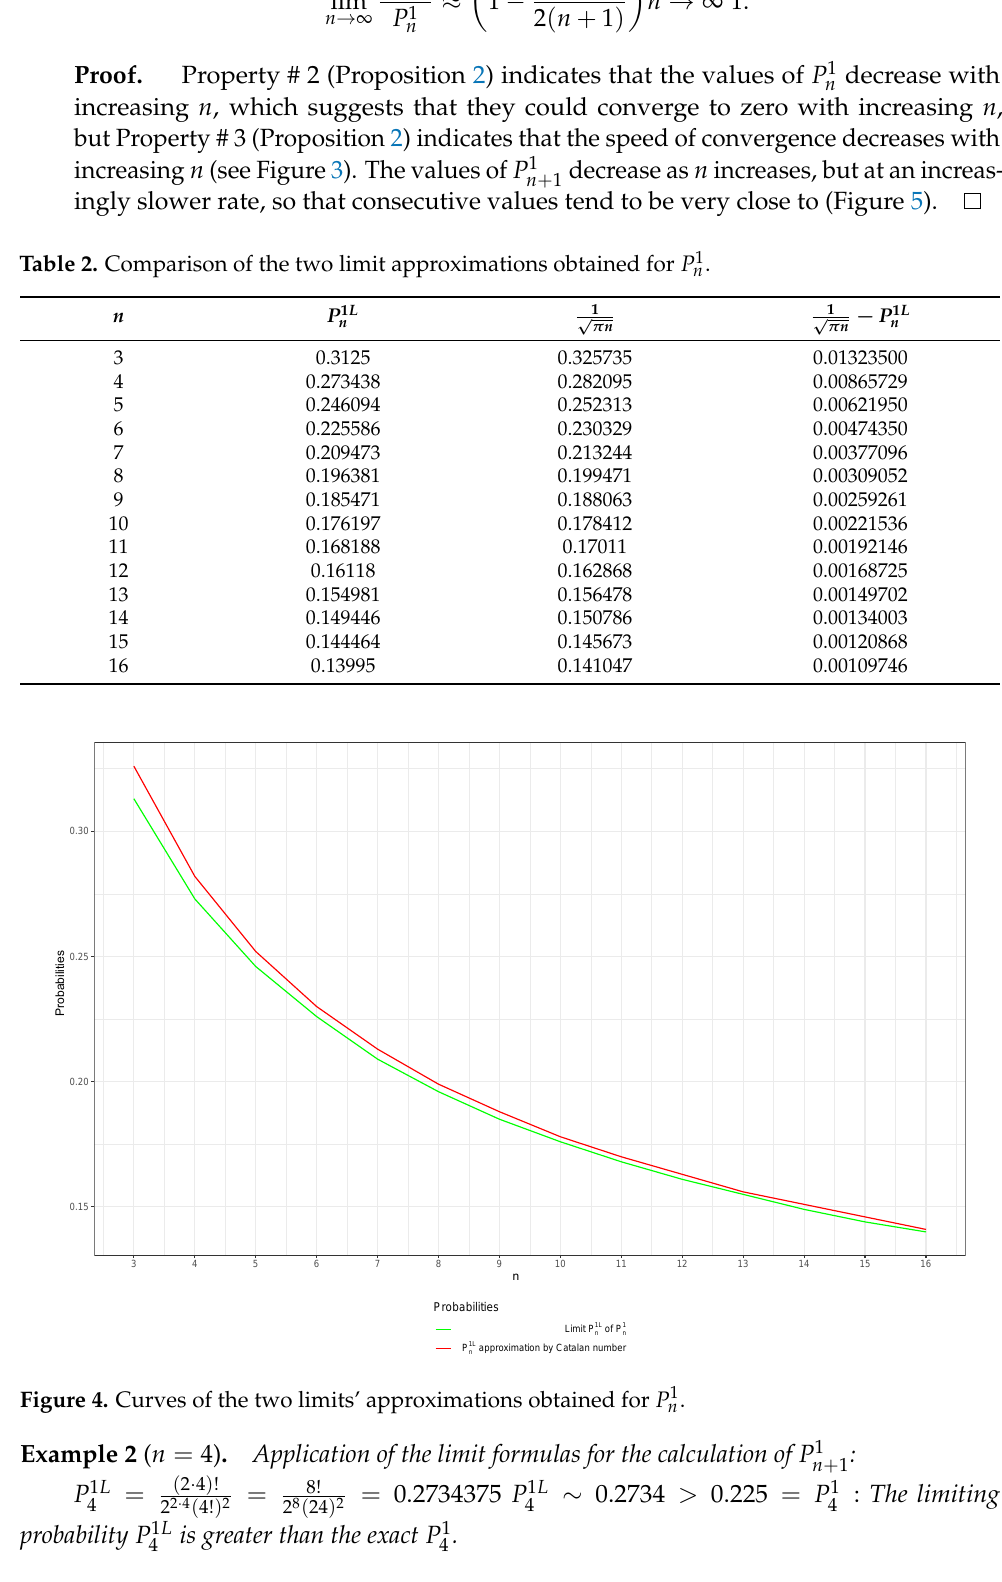
probability P 1 L